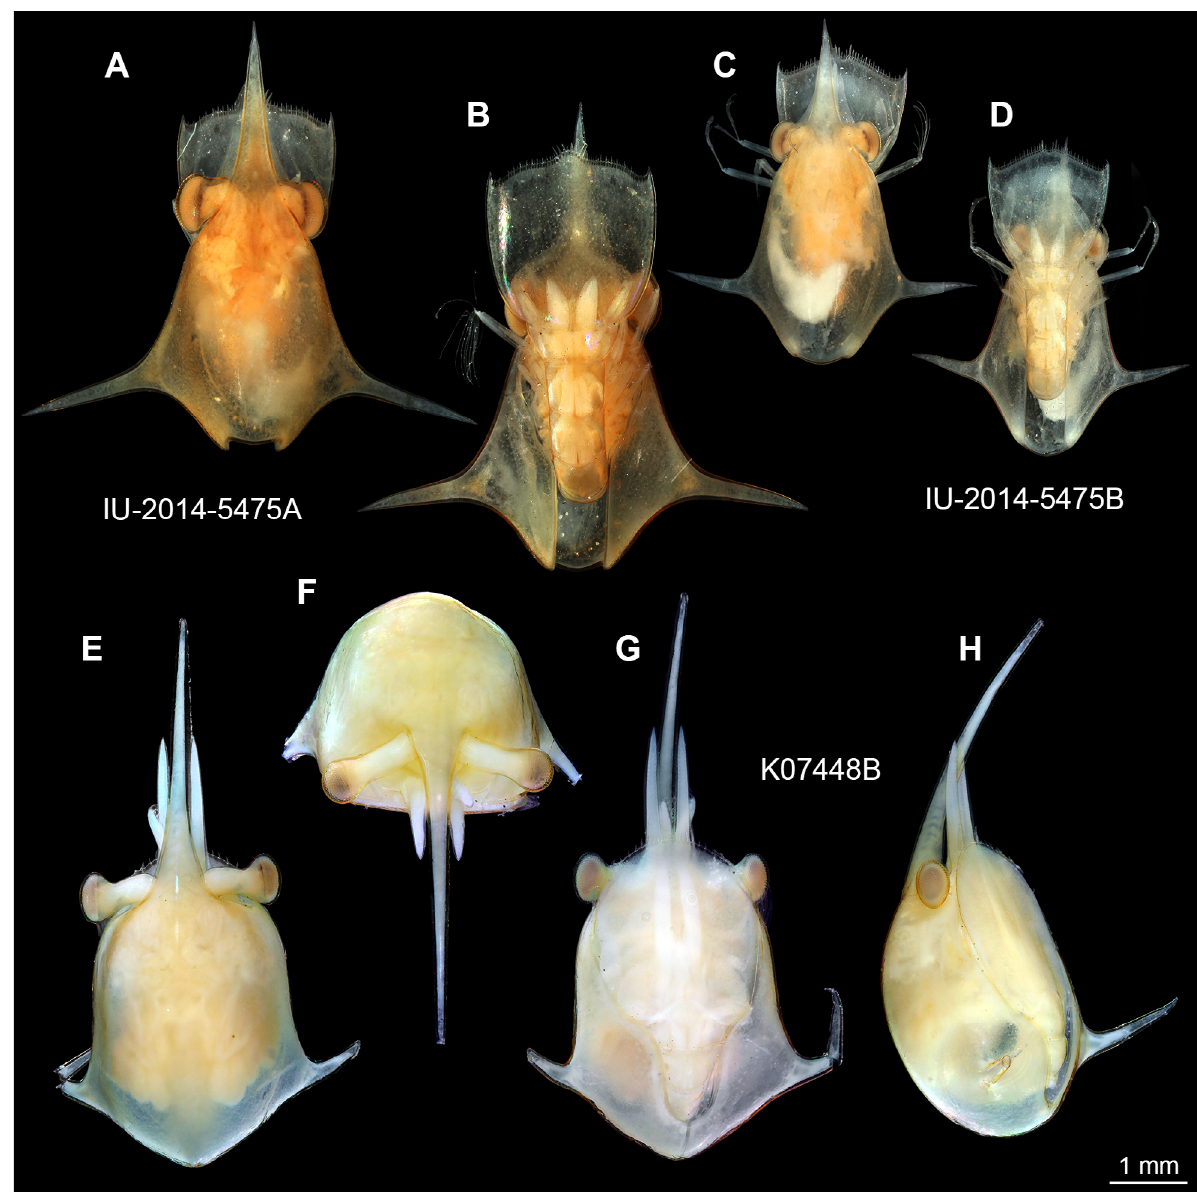
Figure 4. Larvae of the group Hippidae, museum specimens under cross-polarized light. A, B : Specimen MNHN-IU-2014-5475A. A . Dorsal view. B . Ventral view. C, D : Specimen MNHN-IU-2014-5475B. C . Dorsal view. D . Ventral view. E–H : Specimen ZMH- K07448B. E . Dorsal view. F . Anterior view. G . Ventral view. H . Lateral